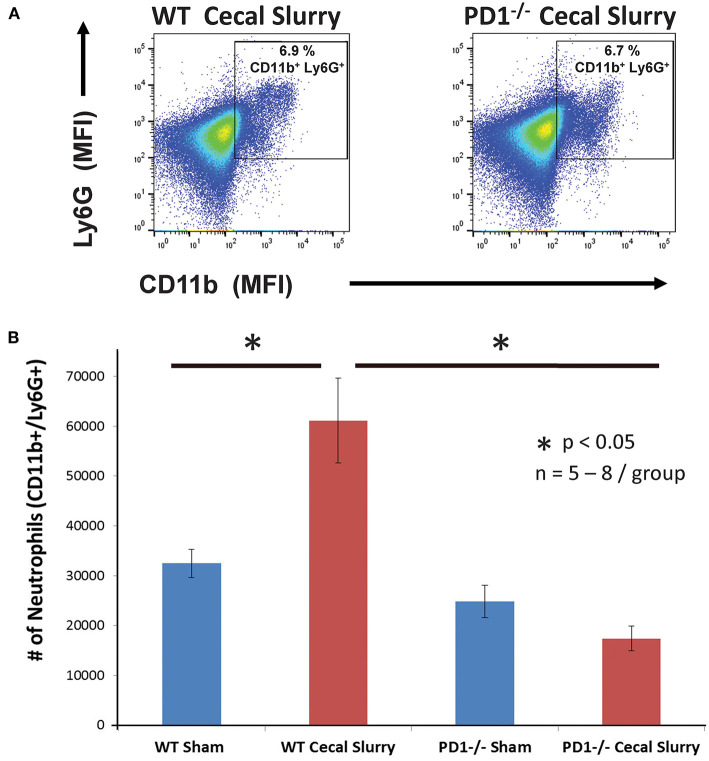
Neutrophils increase in wildtype (WT) but not PD1−/− cecal slurry (CS) mouse lung tissue. (A) Flow cytometry with neutrophils being gated as CD11b and Ly6G-positive among lung samples for WT-CS group vs. PD1−/− CS mouse (paired representative dot-plots). Mean Fluorescence Intensity (MFI). The summary data from repeated experiments indicate a marked rise in the neutrophil number (B) in WT CS lung tissue when compared to Shams. However, this was not changed between PD1−/− Sh and CS animals. Mean ± SEM, n = 5–8 per group; *P < 0.05 vs. WT CS group; ANOVA with Holm–Sidak post-hoc analysis.